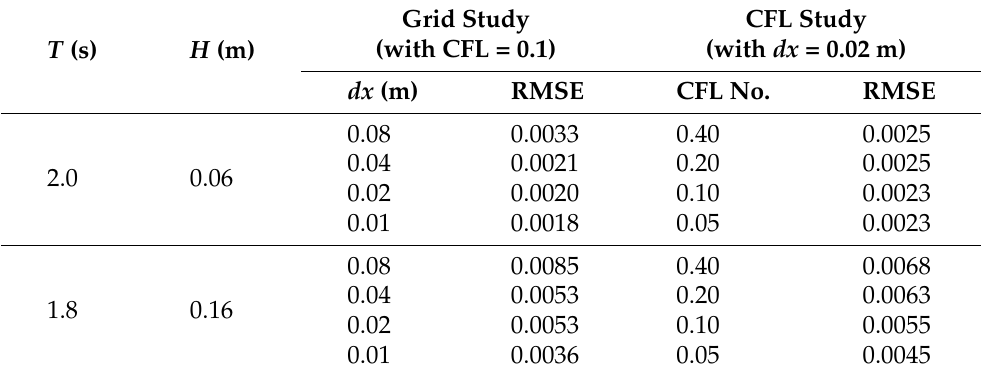
Table 2. Accuracy comparison between numerical and experimental wave